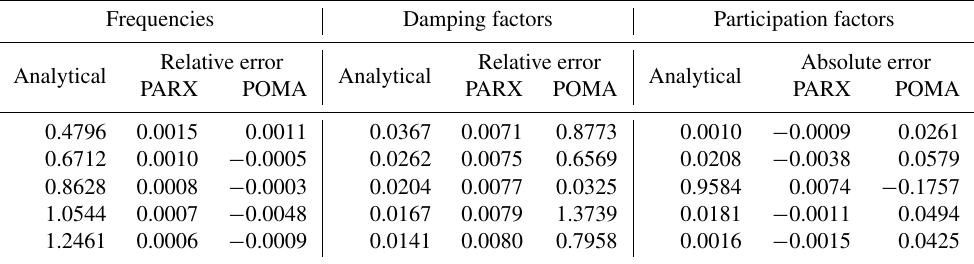
Table 4. Analytical results and estimation errors of blade in-plane modal parameters.